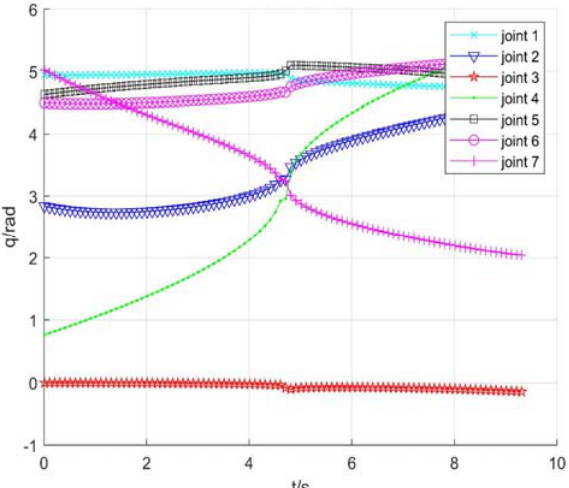
Figure 7. Position of each joint.